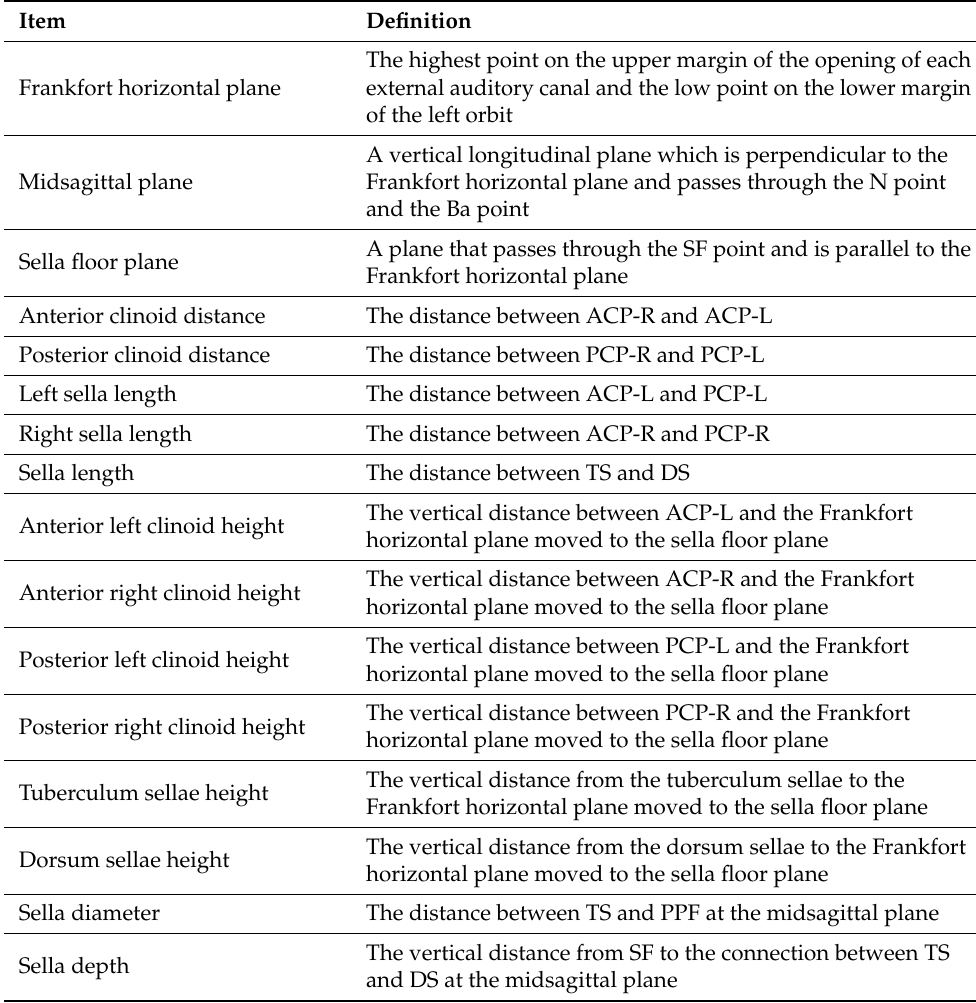
Table 1. Reference planes and the definitions of linear